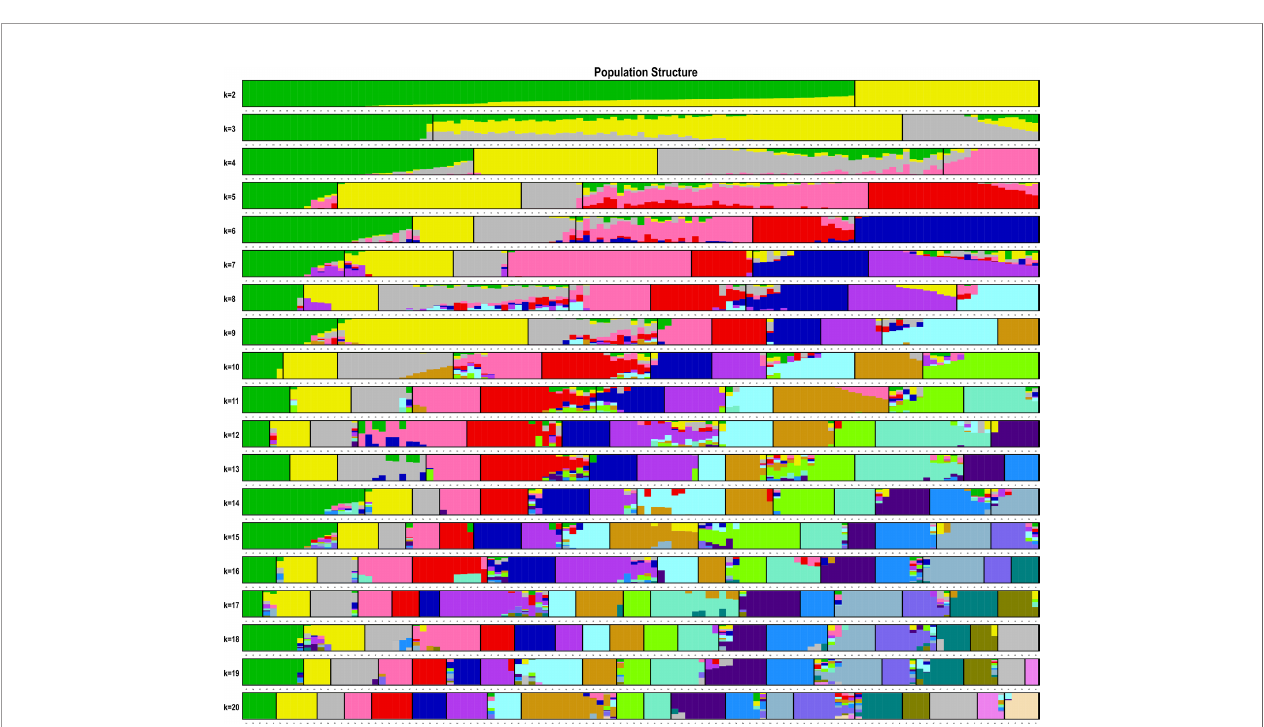
FIGURE 4 | Pattern of variation among the 13 cultivars based on SNPs. The x -axis showed different cultivars. The y -axis quanti fi ed the membership probability of cultivars belonging to different groups. Colors in each row represented structural components.